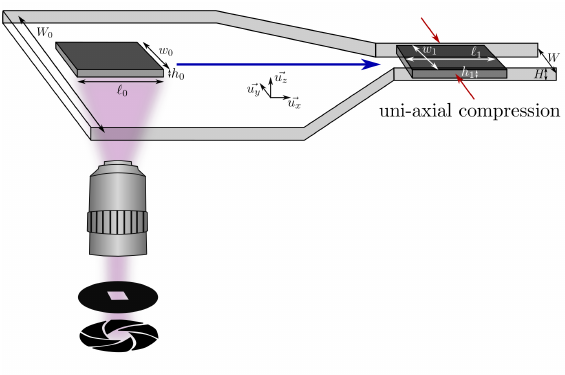
Figure 1. In situ fabrication of a particle using a microscope-based projection lithography technique. UV light is projected into a flat channel through a shutter and a rectangular mask resulting in the fabrication of a hydrogel particle surrounded by uncured solution. The slab is then pushed into a constriction by applying an external flow. When the particle has completely entered the narrow region of the channel the flow is stopped and the particle experiences uni-axial